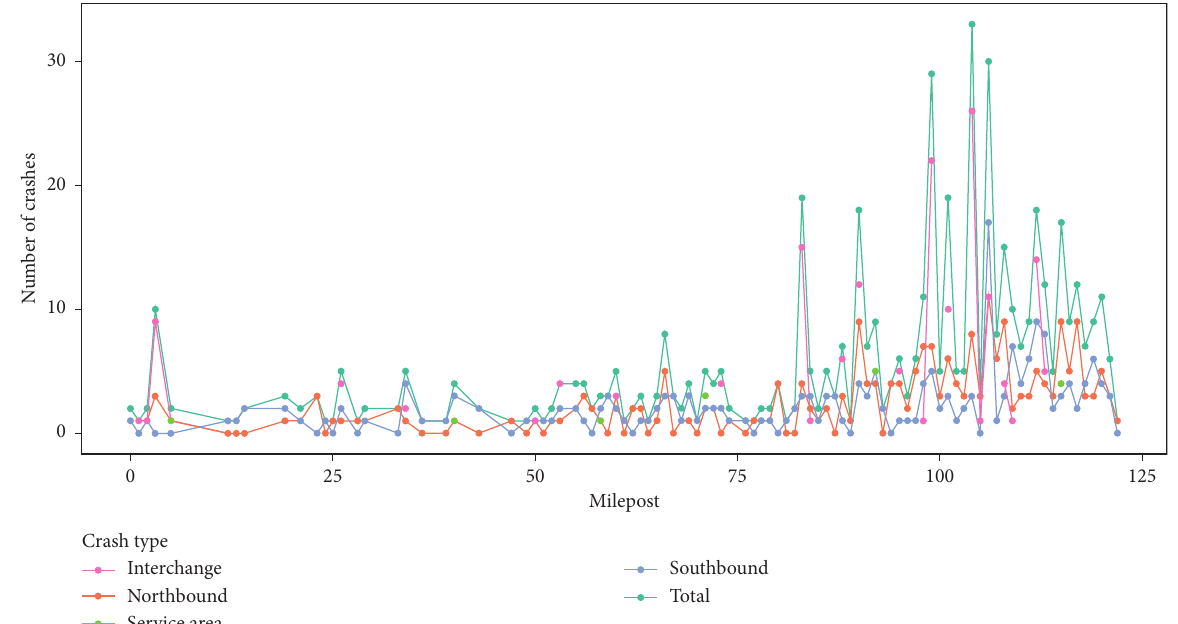
Figure 4: Number of crashes in terms of NJTP mileposts (March